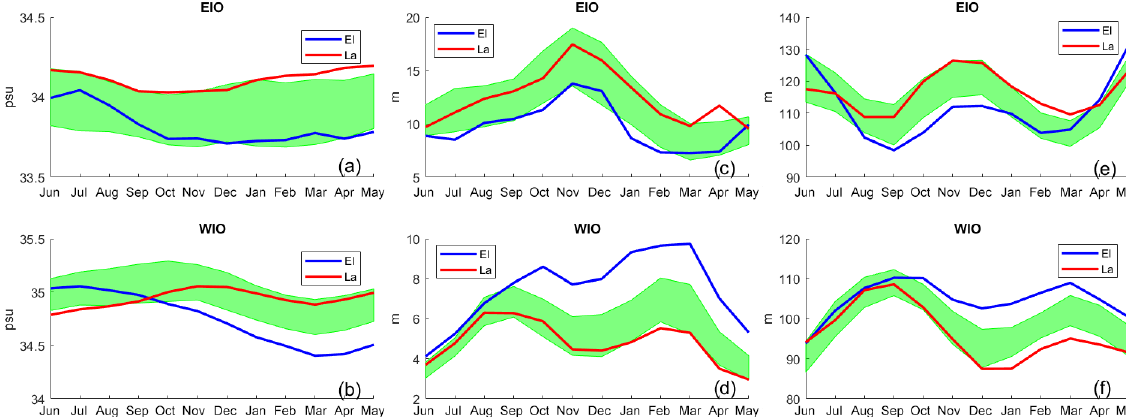
Figure 10. Same as Fig. 9 but the composite in the El Niño and La Niña years.